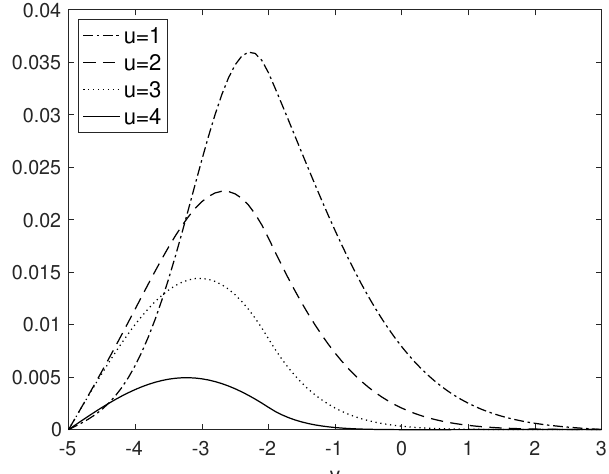
Figure 2. Graphs of the joint density in (11) where X = W is a standard Brownian motion with a = − 5, b = 3, (cid:96) = − 2, t = 5, and N = 30. We used 16 terms in the Gaver–Stehfest